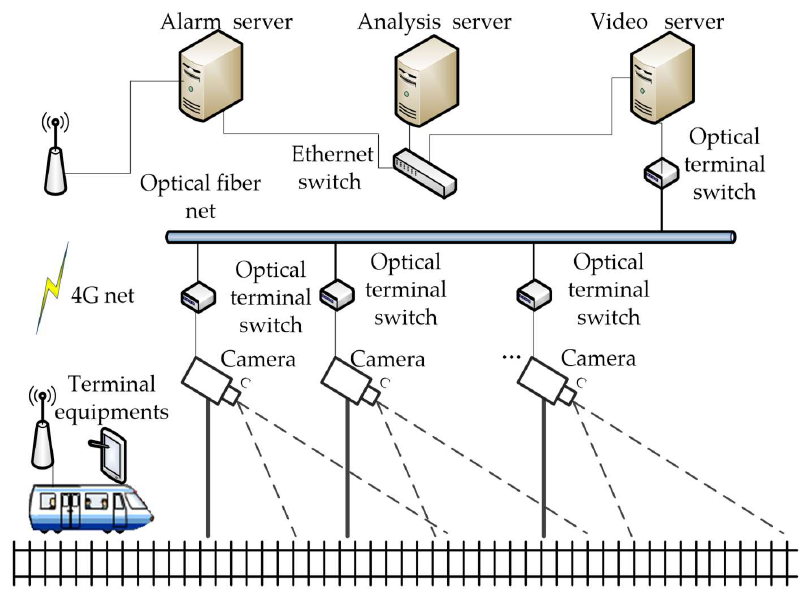
Figure 1. Structure of the railway intrusion detection system.